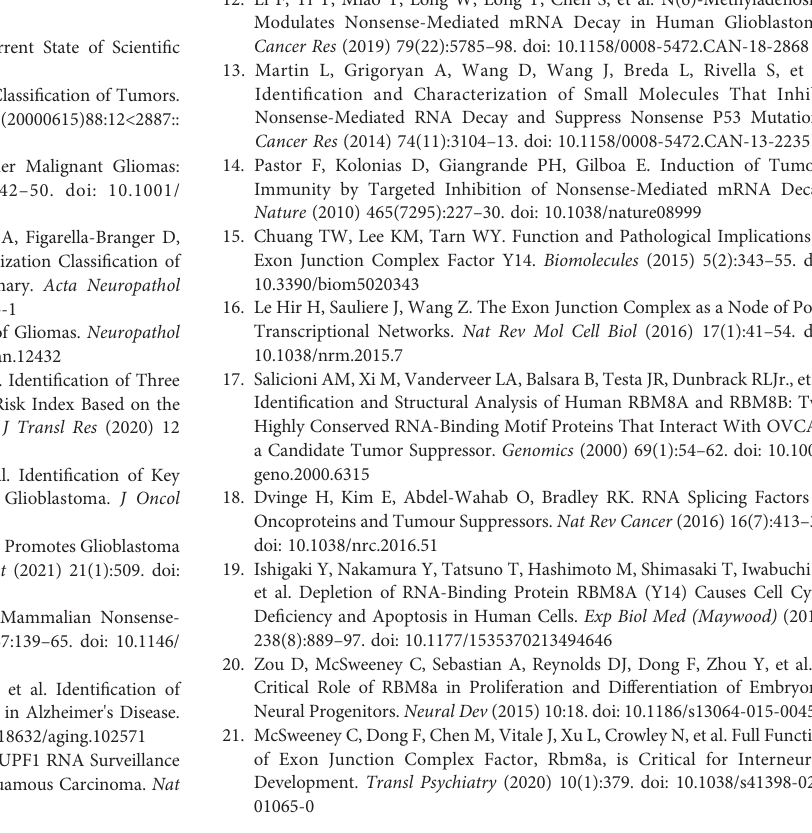
Supplementary Figure S2 | Diagnostic and prognostic value of the GSVA score based on GBM data from TCGA and CGGA. (A) Receiver operating characteristic curve of the GSVA score. (B) Overall survival curves based on GSVA score. Supplementary Figure S3 | Tumor volume in each group. Data are presented as mean ± SD, and differences were assessed for signi fi cance using the two-tailed Student ’ s t